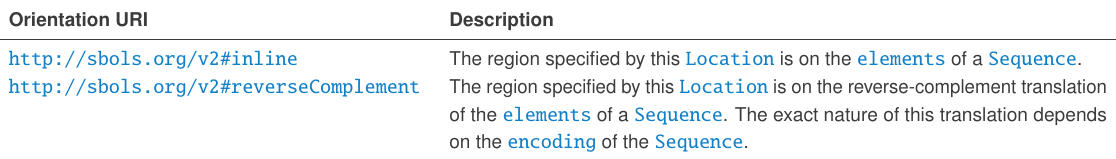
Table 6: REQUIRED URI s for the orientation